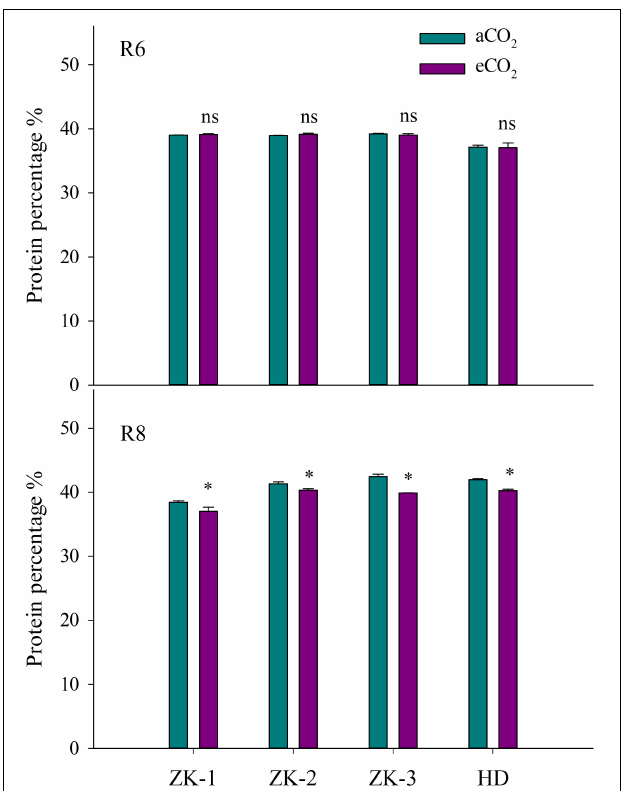
FIGURE 2 | Boxplot shows the mean response ratio of the seed free amino acid concentrations of four soybean cultivars under elevated CO 2 at fresh edible (R6) and mature stages